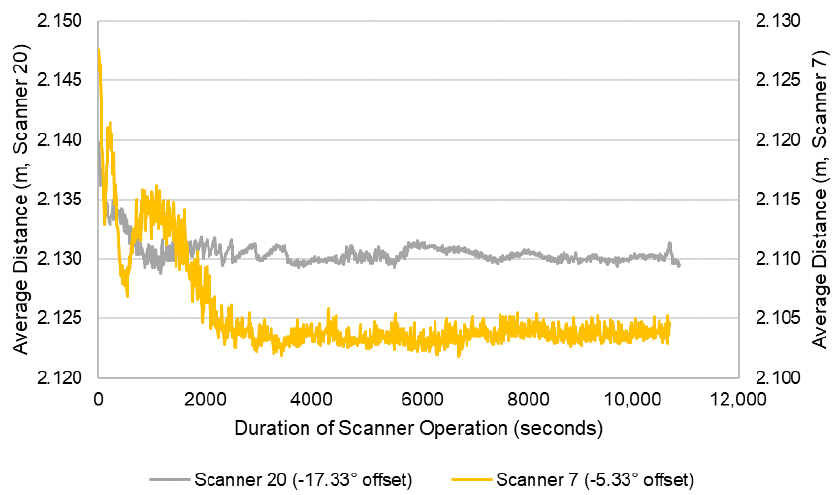
Figure 15. Comparison of individual channels’ average measured distances for the Velodyne ® HDL– 32E. The two pairs shown are the ones with the highest (channel 20) and lowest (channel 7) precision in their averaged measurements over time.